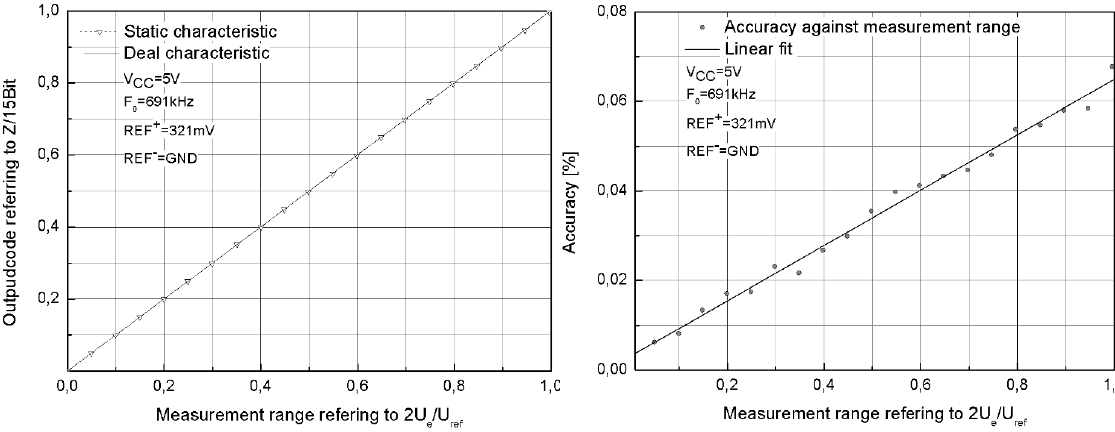
Figure 6. The performance characteristics of the measurement